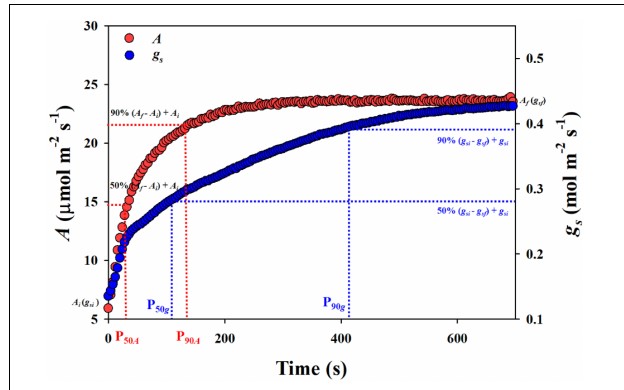
FIGURE 1 | The calculation of stomatal conductance g s and photosynthetic rate A in response to a stepwise increase in light intensity. P 50 g and P 90 g , the time taken for g s to reach 50 and 90% of the difference between the initial and final g s . P 50 A and P 90 A , the time taken for A to reach 50 and 90% of the difference between the initial and final A